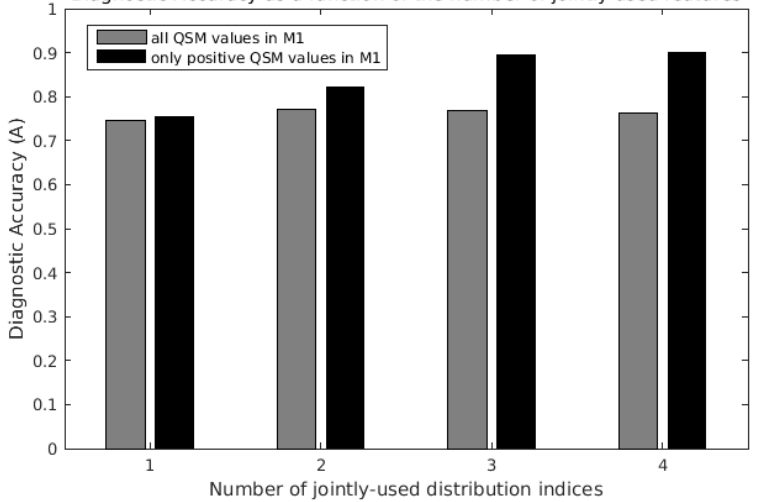
Figure 4. Maximum diagnostic accuracy of support vector machine (SVM) classifiers as a function of the number of QSM distribution indices jointly considered. The last black bar on the right indicates the maximum diagnostic accuracy (A = 0.90) obtained with the joint use of all four distribution indices μ+, σ+, S+ and K+ of QSM positive values in the primary motor cortex (M1).